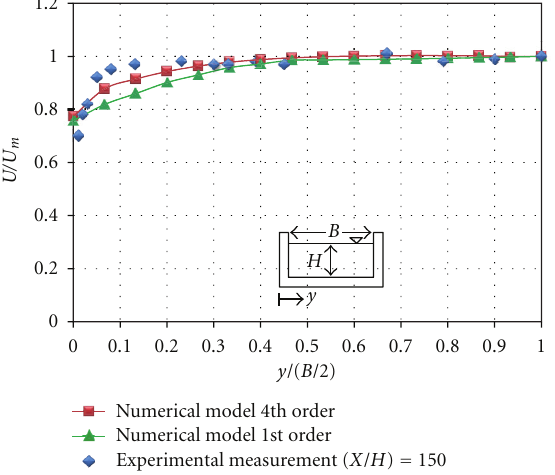
Figure 5: Horizontal velocity distribution.